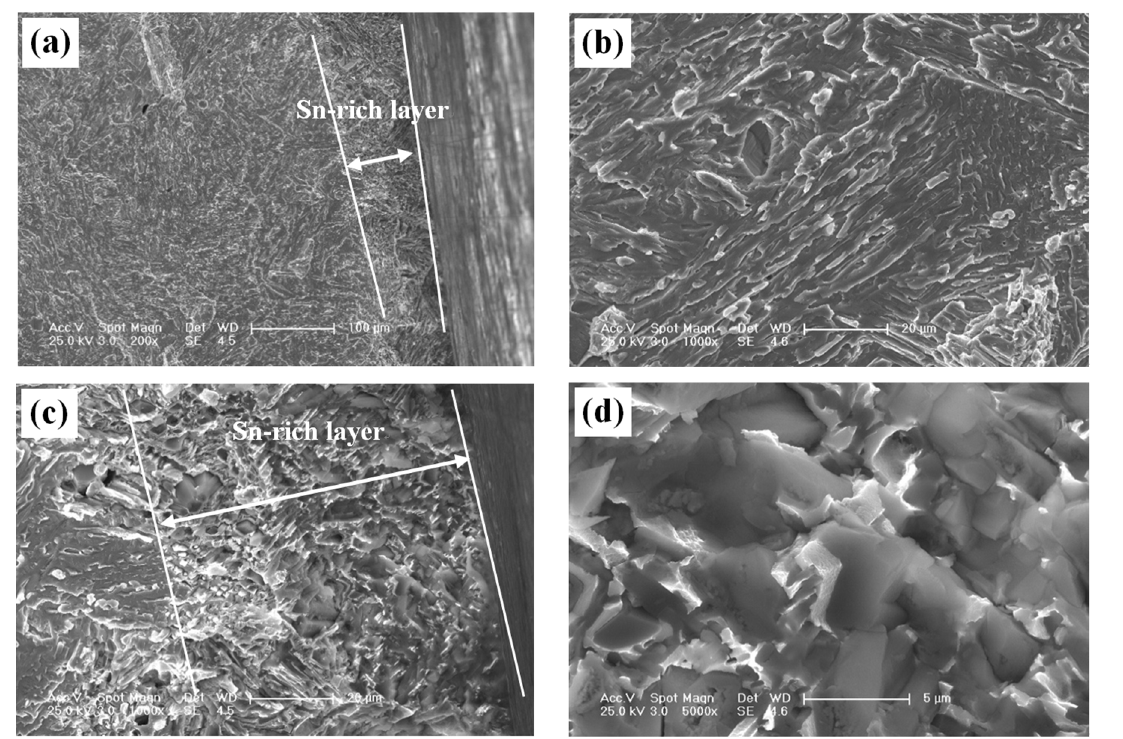
Figure 6. Cross-section fracture surface SEM morphologies of the sword: ( a ) low magnification; ( b ) high magnification of the body; ( c ) portion of the Sn-rich layer; ( d ) high magnification of the Sn-rich layer.